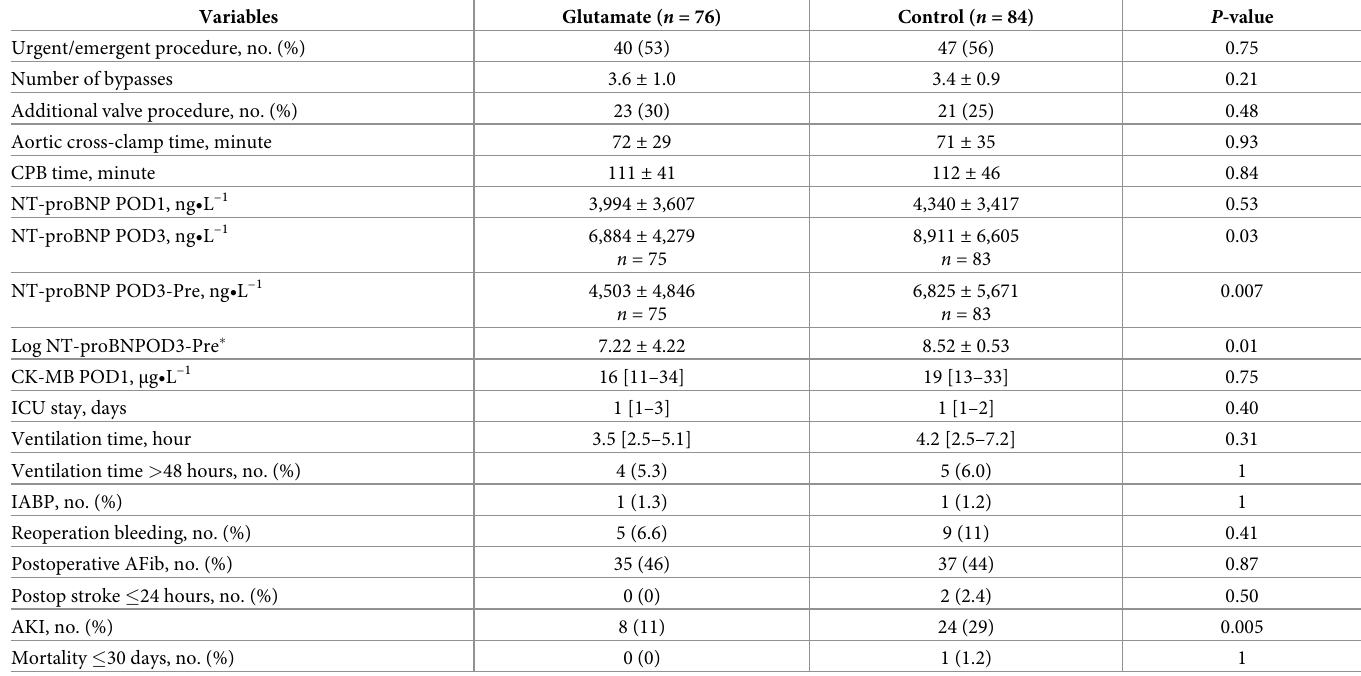
Table 4. Intraoperative and postoperative characteristics of patients without diabetes in the glutamate group and in the control group (saline). Variables Glutamate ( n =